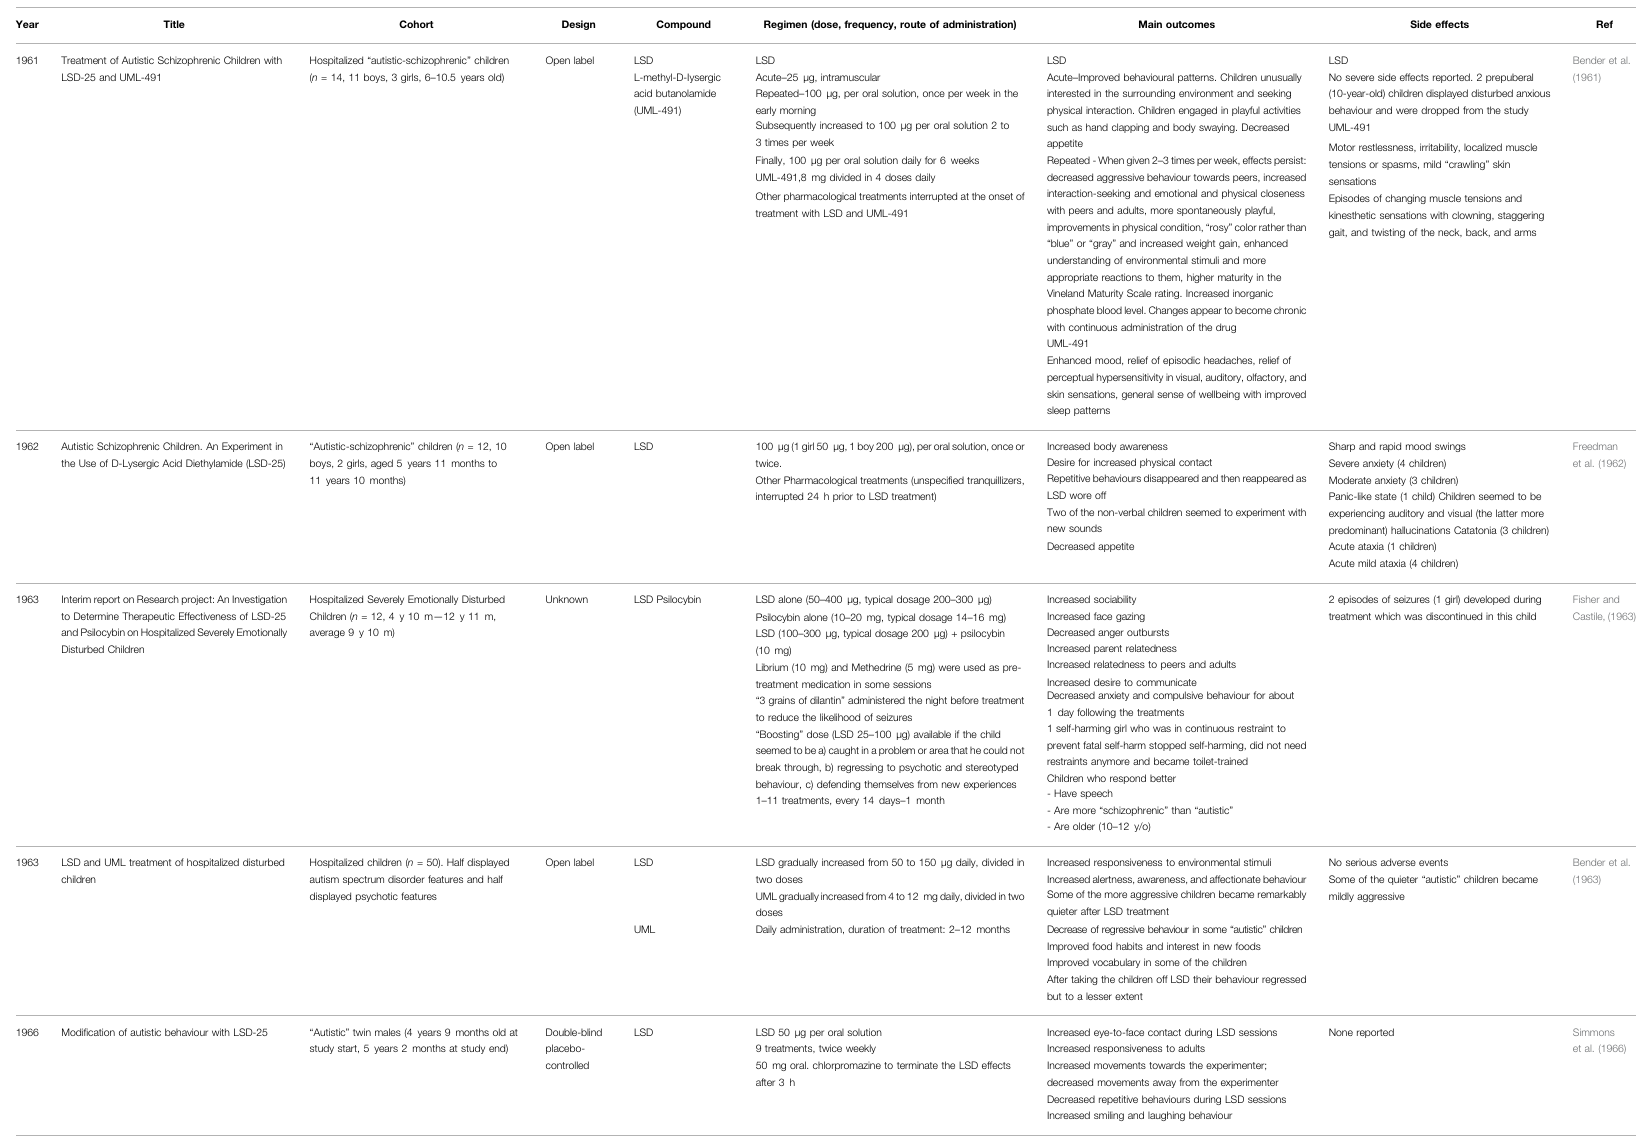
TABLE 2 | Early clinical trials (1961 – 1970) assessing the use ofpsychedelics in “ autistic schizophrenic ” children. The terms “ autistic ” and “ schizophrenic ” do not re fl ect the currently approved terminology of the DSM-V, but rather the terminology that was used at the time of these early